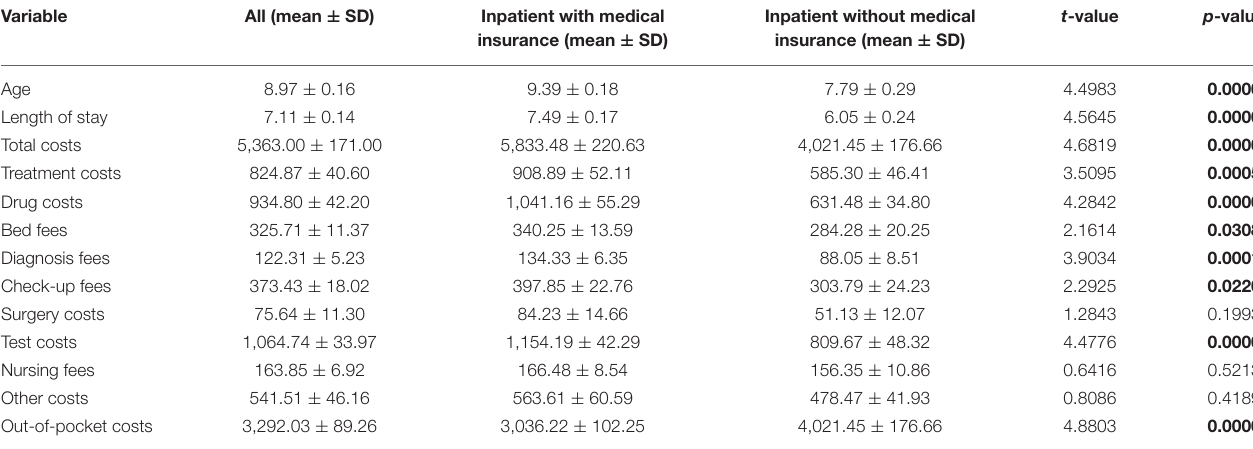
TABLE 2 | Hospitalization costs of children with type 1 diabetes